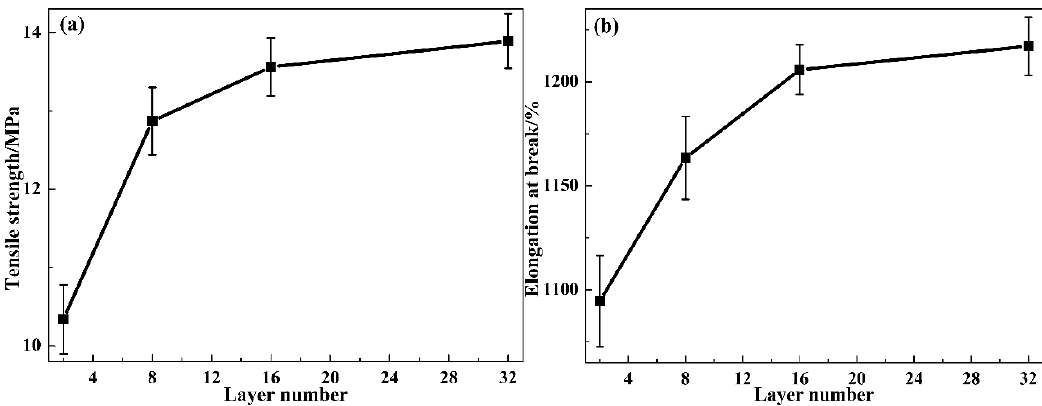
Figure 8. Mechanical properties of the TP multilayer system: ( a ) tensile strength and ( b ) elongation at break.